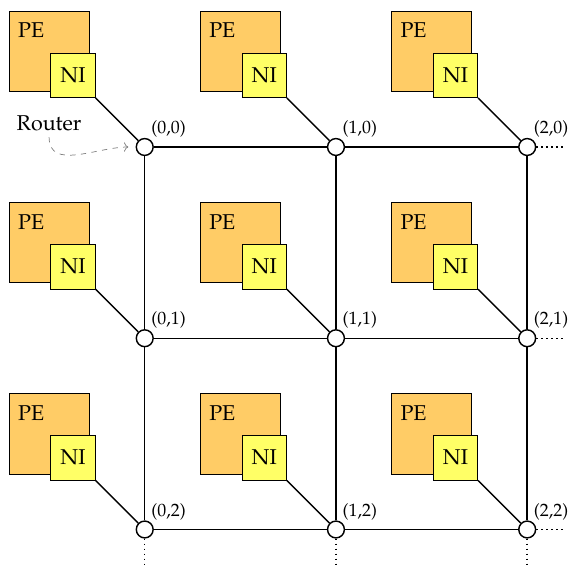
Figure 1. Example Networks-on-Chip (NoC) topology (2D mesh) with attached processing elements (PE) and network interfaces